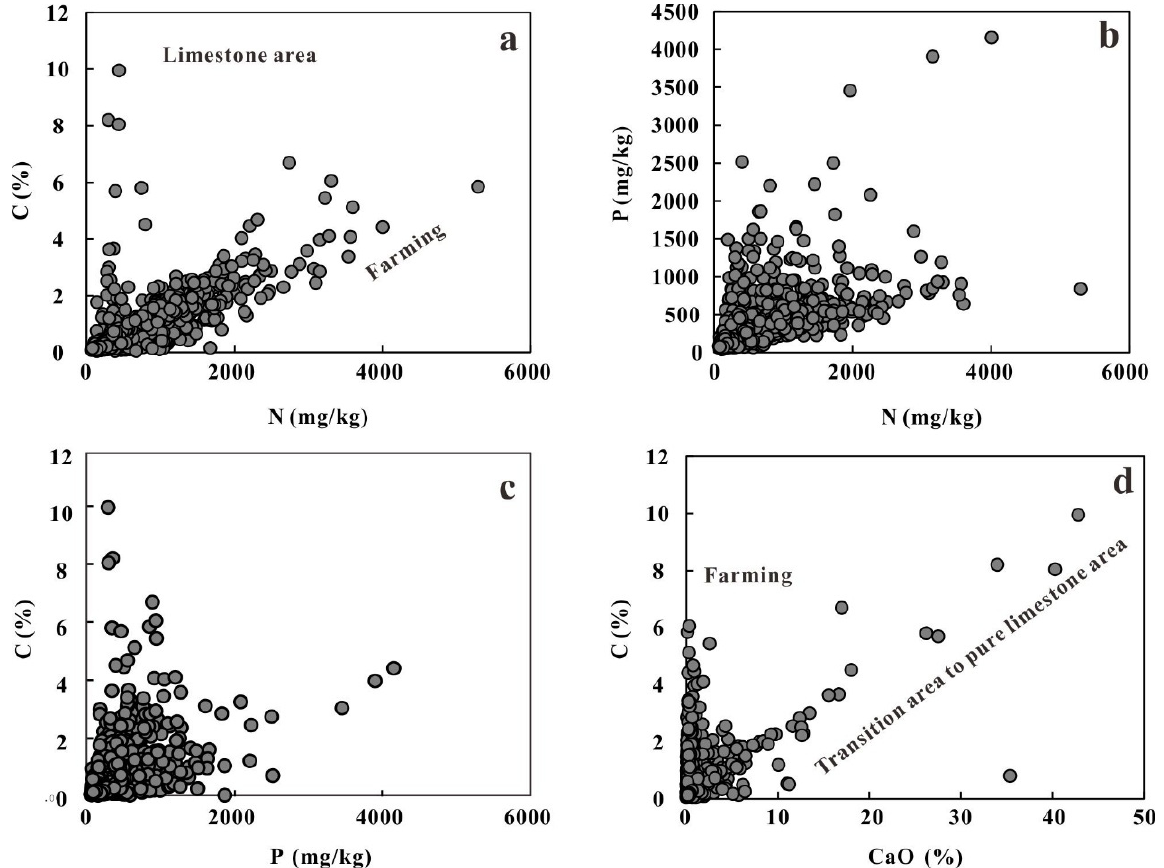
Figure 11. ( a ) Correlation scatter diagram between C and N, ( b ) Correlation scatter diagram between P and N, ( c ) Correlation scatter diagram between C and P, ( d ) Correlation scatter diagram between C and CaO.